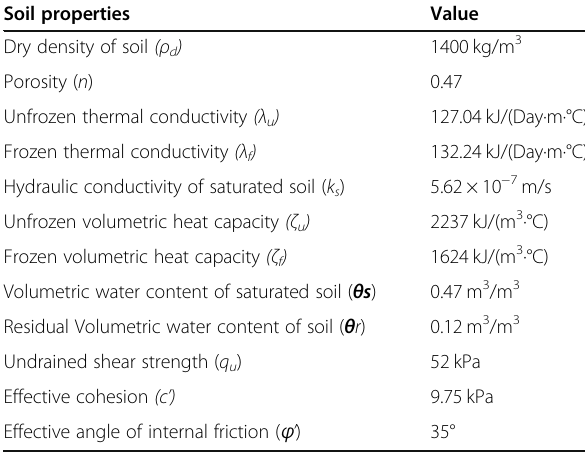
Table 2 Soil properties used for the simulation